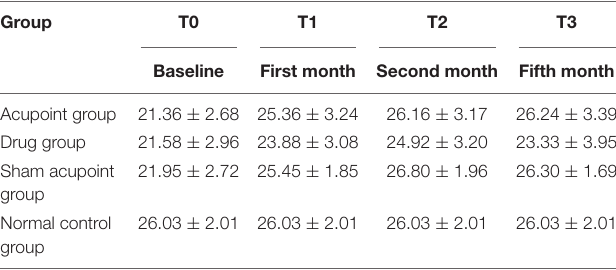
TABLE 5 | Montreal cognitive assessment (MoCA) scores in four groups at different time